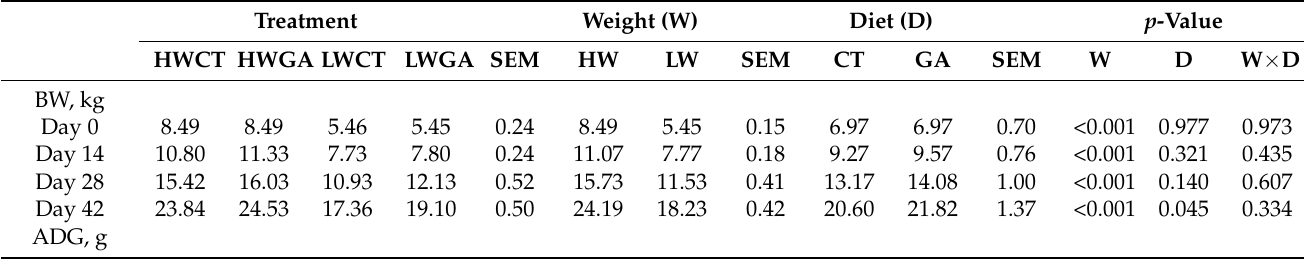
Table 2. Effect of dietary GA on growth performance of high and low weaning weight piglets.